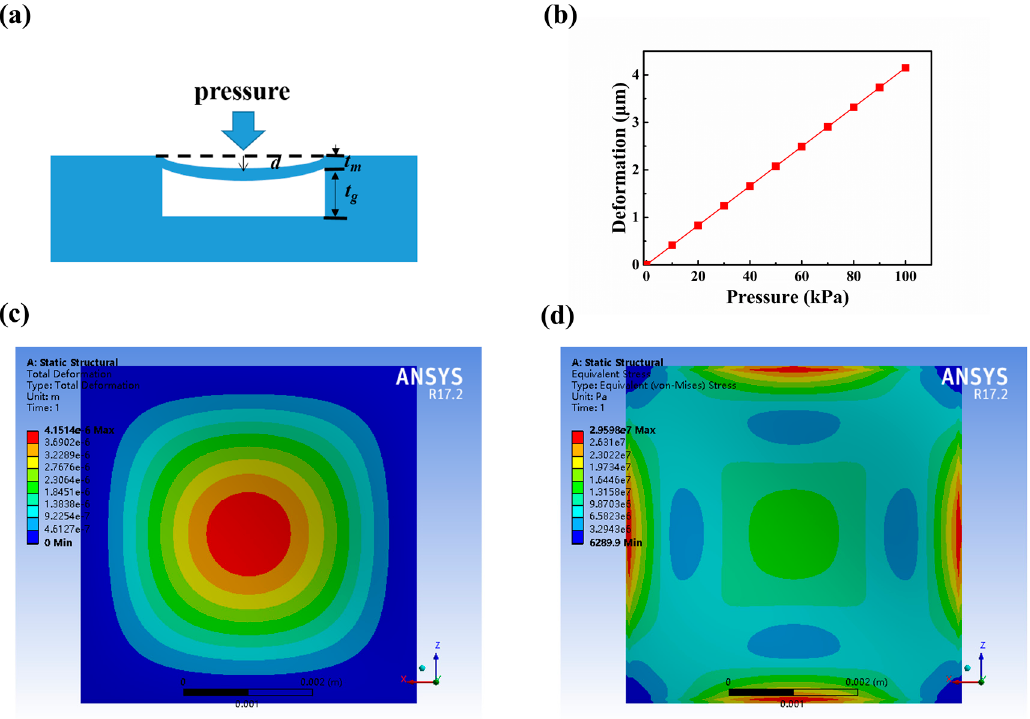
Figure 2. ( a ) Schematic diagram of the thin plate deformation model. ( b ) The sensing membrane deformation versus the applied pressure. ( c ) The simulated result of the sensing membrane deformation under 100 kPa pressure. ( d ) The simulated result of the equivalent stress distribution in sensing membrane under 100 kPa pressure.